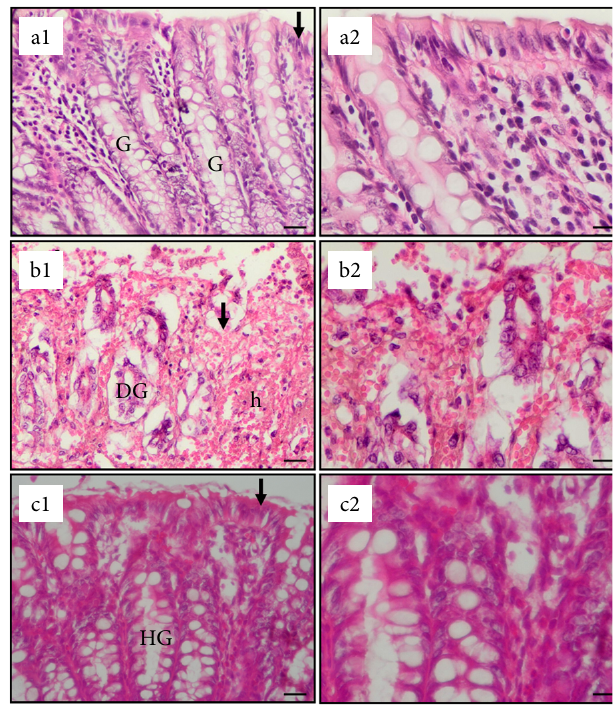
Figure 1 - Microscopic images of colon sections of rats with